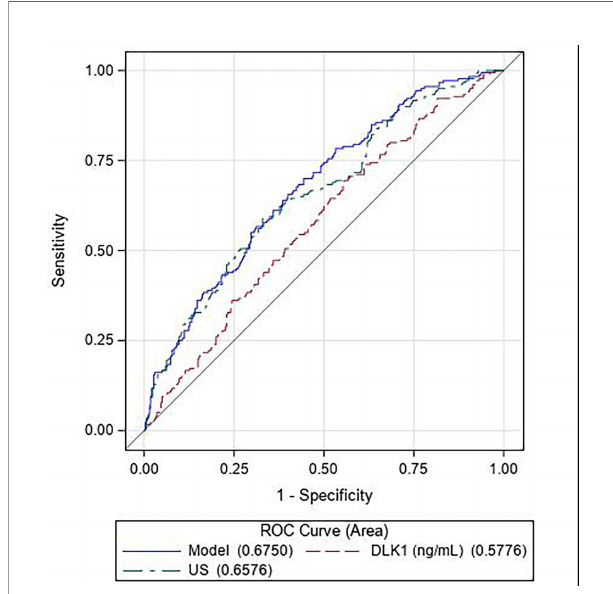
FIGURE 2 | Receiver operating characteristic (ROC) curves for the predictive performance of DLK1 alone ( — — — , red), ultrasound data (fetal head circumference, fetal abdominal circumference, femur length, and gestational age at measurement) alone ( — - — , green), and DLK1 and ultrasound data combined ( —— − , blue). (N = 180 cases, 340